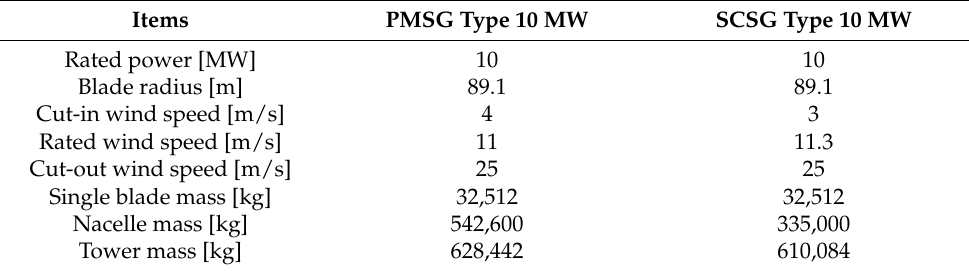
Table 1. Data of the 10 MW class FOWT for the platform design.